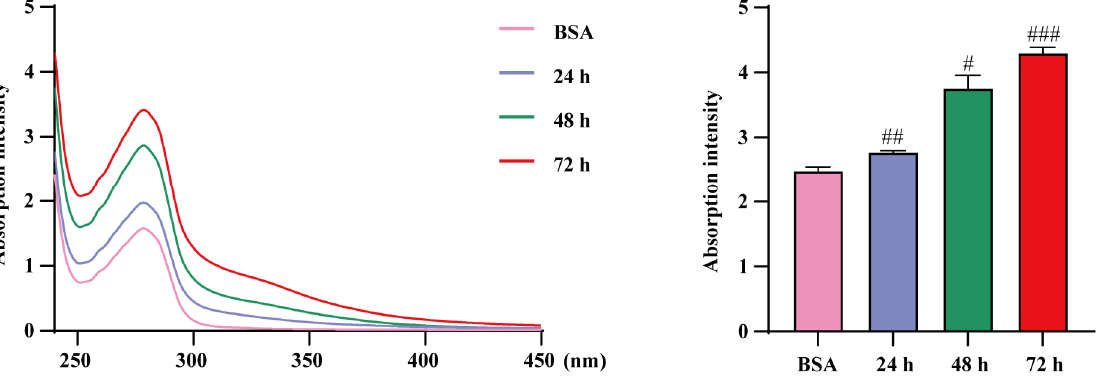
Figure 5. Determination of BSA–fructose UV spectroscopy. “#” represents the comparison with the BSA group ( ### p < 0.001, ## p < 0.01, and # p <